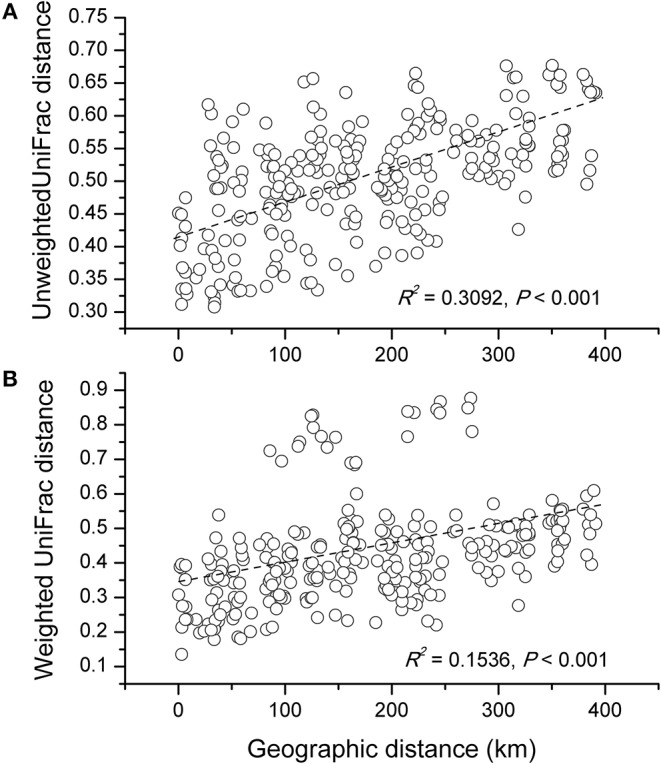
Correlationship between the unweighted (A) and weighted (B) UniFrac differences in soil microbial community structure and the distance of microbes-inhabiting geographic locations.